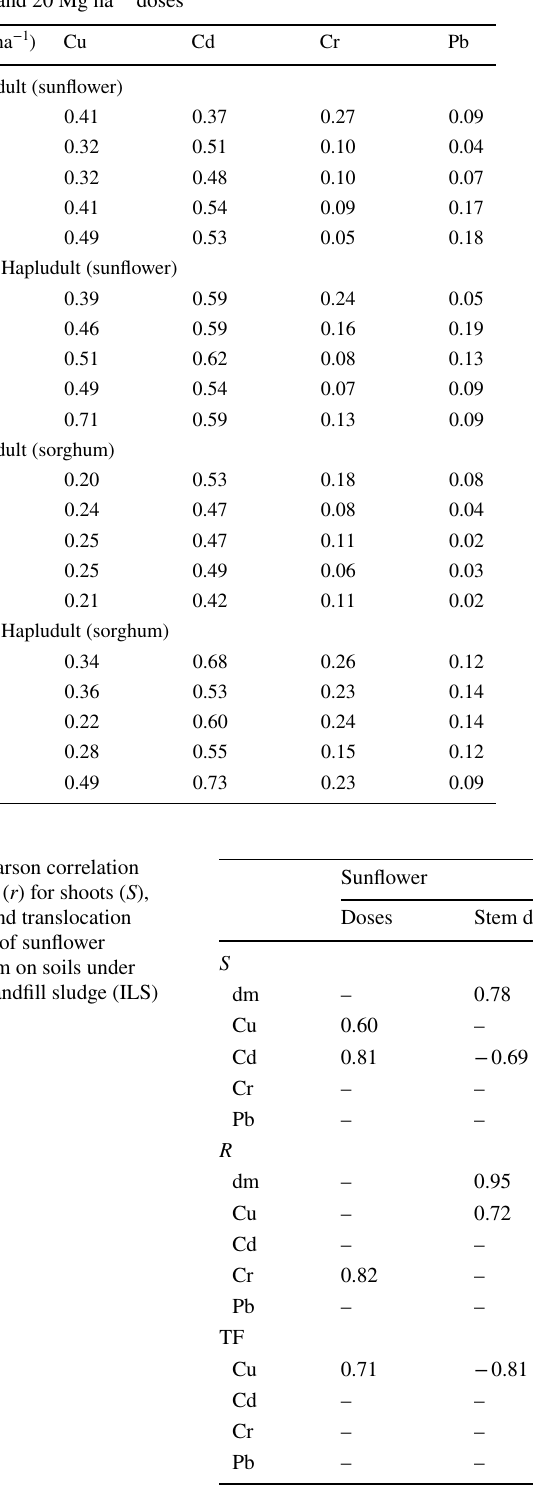
and the roots biomass production (– 0.63) of the sunflower plants. Concentrations of copper (Cu) in the roots was cor- related ( r ) positively with the sunflower diameter (0.72) and roots biomass (0.65) (Table 4). The translocation factor of Cu in sunflower plants had positive correlations ( r ) with the ILS doses (0.71) and negative correlations with the stem